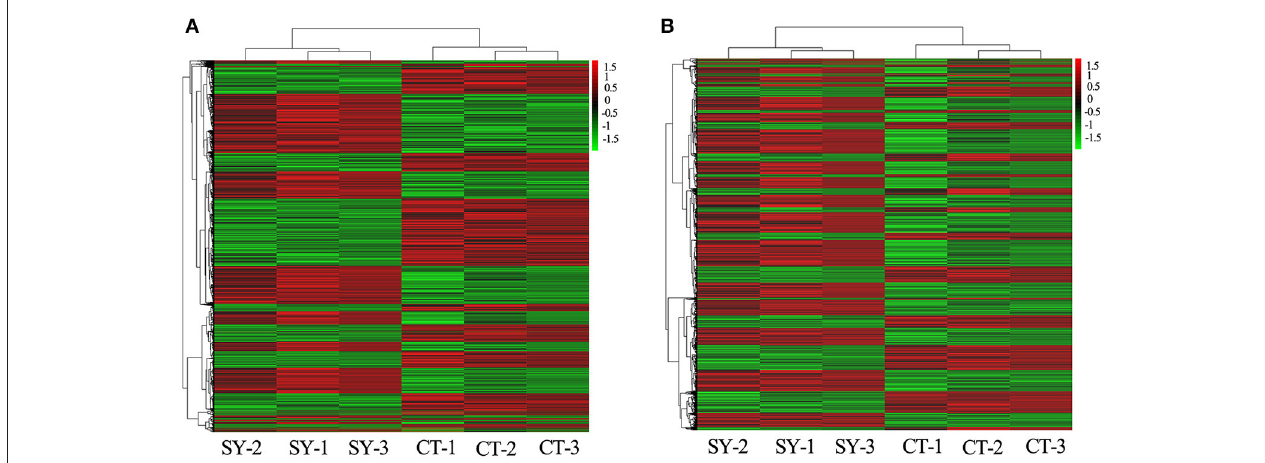
FIGURE 1 | Heat maps of the differentially expressed lncRNAs and mRNAs between the healthy control ( n = 3) and neurosyphilis groups ( n = 3). (A) The dendrogram shows the relationships among the lncRNA expression profiles in the CD4 + T cells acquired from neurosyphilis patients and healthy controls. (B) The dendrogram demonstrates the relationships among the mRNA expression profiles in the CD4 + T cells acquired from neurosyphilis patients and healthy controls. “SY-” and “CT-” represent the neurosyphilis group and control group, respectively. The red block indicates up-regulated expression, and the green block indicates down-regulated expression.